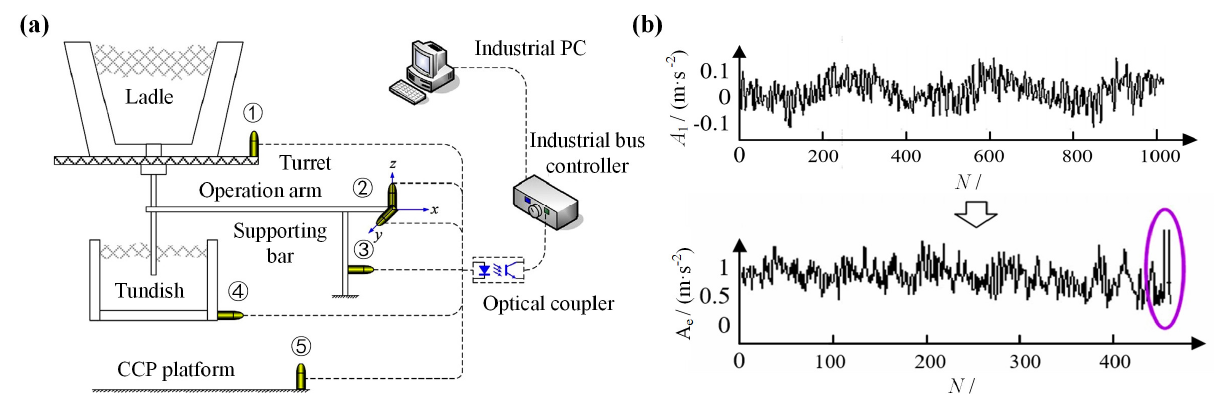
Figure 4. Vibration signal detection of steel flow. ( a ) Signal measurement point placement. ( b ) Time- domain vibration signal. Reproduced with the permission of Elsevier. (Reprinted with permission from Ref. [42]. 2014, Elsevier.)